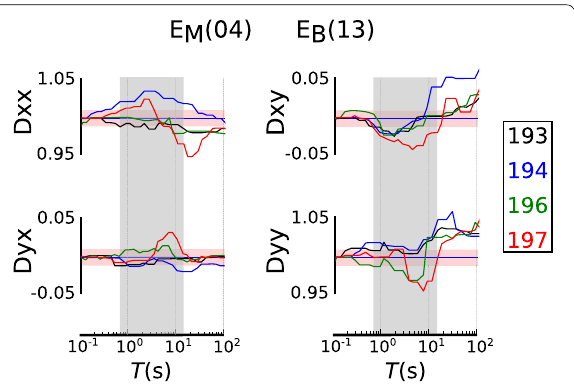
Fig. 11 Transfer functions comparing stations 13 ( E B ) and 04 ( E M ) between days 193 and 197. The x -axis shows the period in seconds, and the grey shaded area represents the approximate dead band. The blue horizontal lines represent the identity matrix transfer functions. The pink shaded region represents a noise window of ± 1 % result of introducing a 3 × 1 × 0.4 km conductive body at